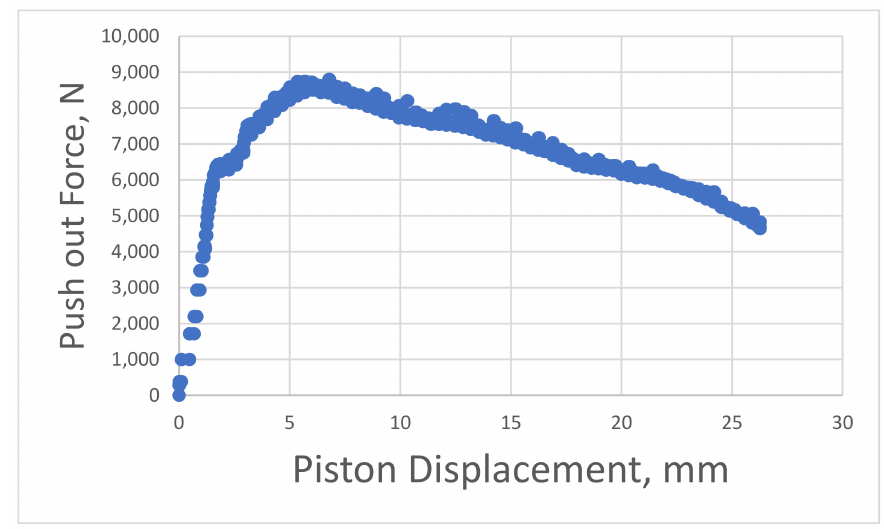
Figure 12. Push-out force versus piston displacement for sample cured for 1 day.